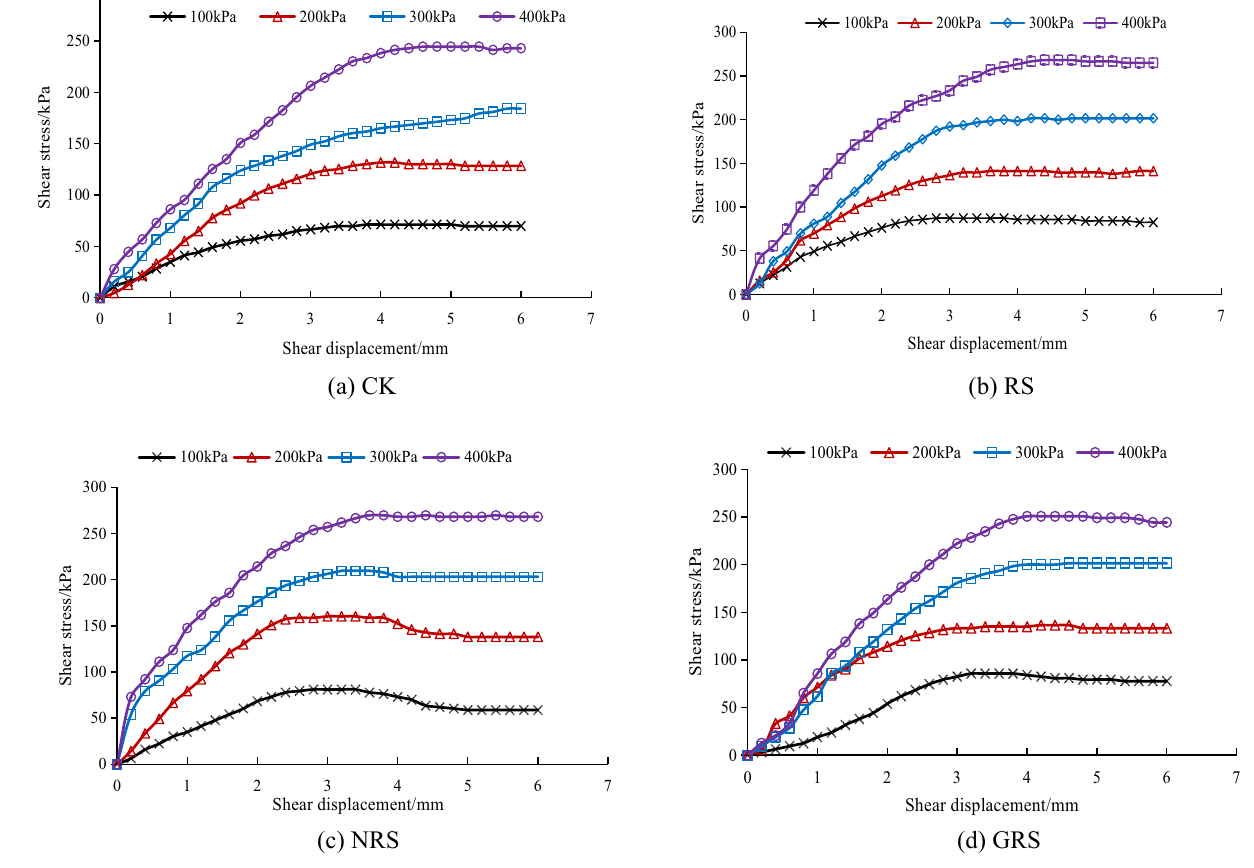
Figure 5. Relationship between shear stress and displacement of root–tailing soil and A. fruticosa under ( a ) CK, ( b ) RS, ( c ) NRS, and ( d ) GRS different interfacial bond